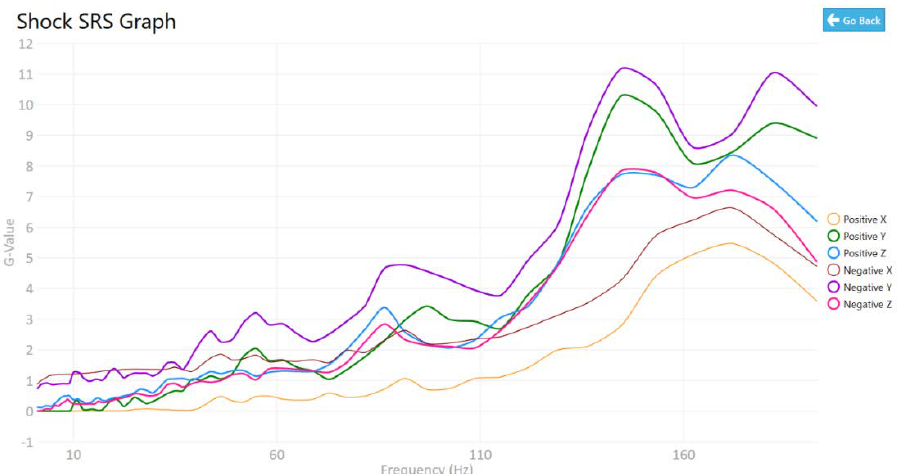
Figure 11. SRS spectrum of shock event number 9 from Figure 11.